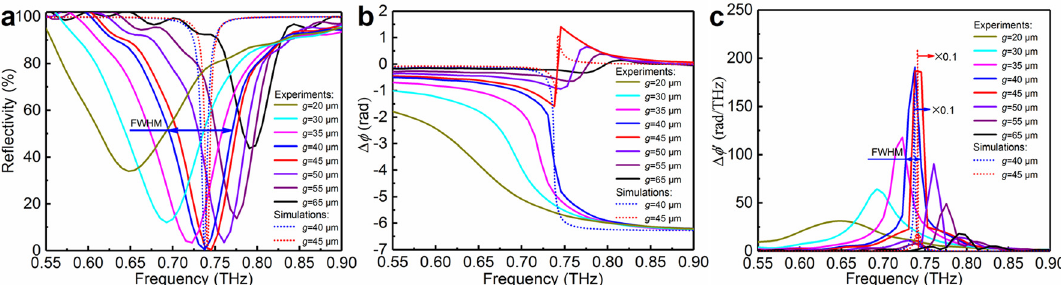
Figure 3: Extracted THz experimental measurement results for various coupling gaps. (a) Reflectivity and (b) phase change Δ ϕ = ϕ ( ω , g ) − ϕ ( ω , g → ∞ )as a function of the frequency for various coupling gaps, g . The solid lines represent the experimental measurements, and the dashed linesrepresentthesimulatedresults.(c)Theabsolutegradientofthechangeinphasebetweenthesampleandreferencespectrum,i.e., Δ ϕ ′ = | d ( Δ ϕ )/ df |